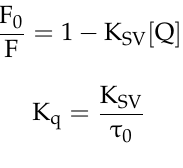
Figure 14. UV-absorption spectra of compound 2 (200 μ M) in the presence of increasing concentration of ct-DNA (0–50 μ M).